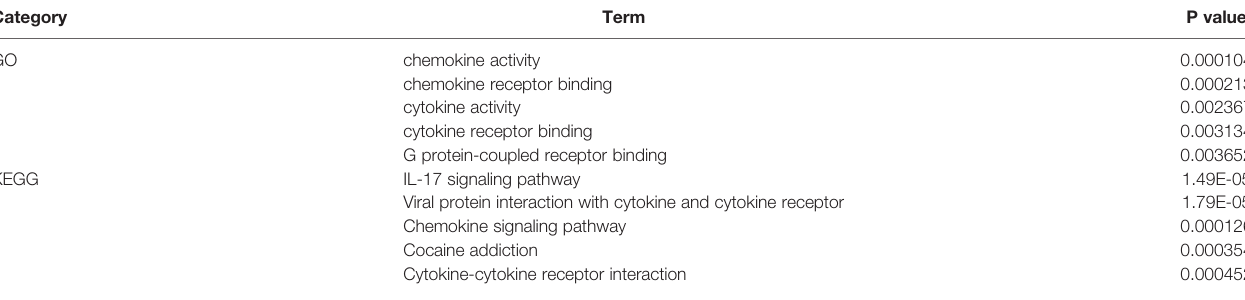
TABLE 3 | The enrichment results of GO and KEGG of hubgenes.